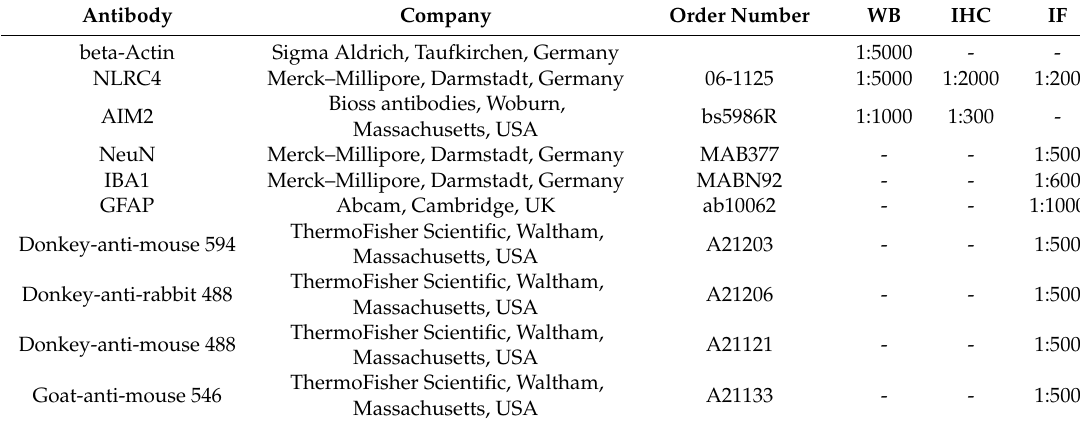
Table 3. List of used antibodies in the